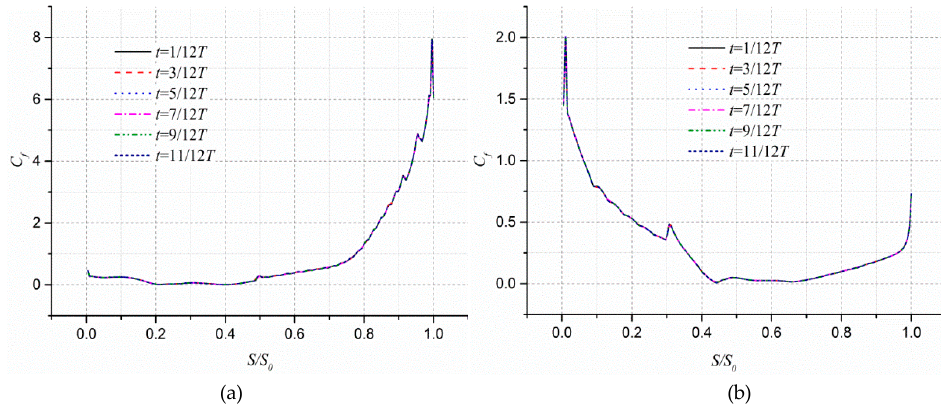
Figure 13. Distribution of the skin friction coefficient on the blade surface for the Z / b 2 = 0.5 cross section: ( a ) pressure surface and ( b ) suction surface.